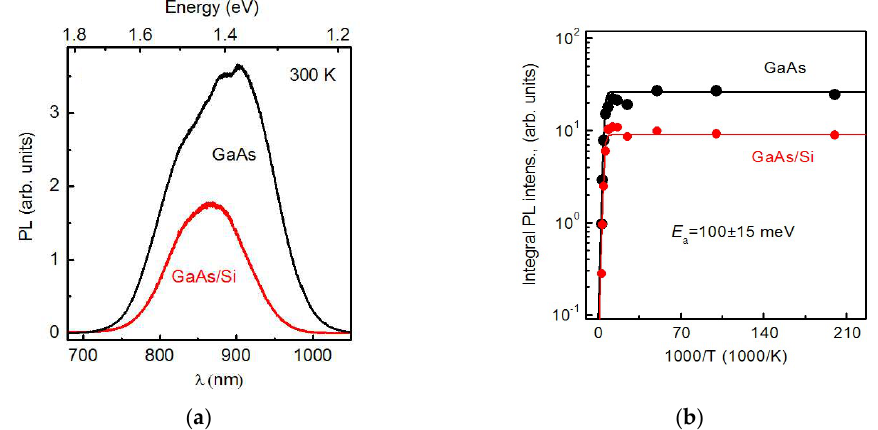
Figure 7. ( a ) Room temperature steady-state PL spectra of the InAs/AlAs HSs with SAQDs, as grown on the GaAs and GaAs/Si substrates. ( b ) The temperature dependences of the integral PL intensity of InAs/AlAs HSs with SAQDs grown on the GaAs and GaAs/Si substrates.